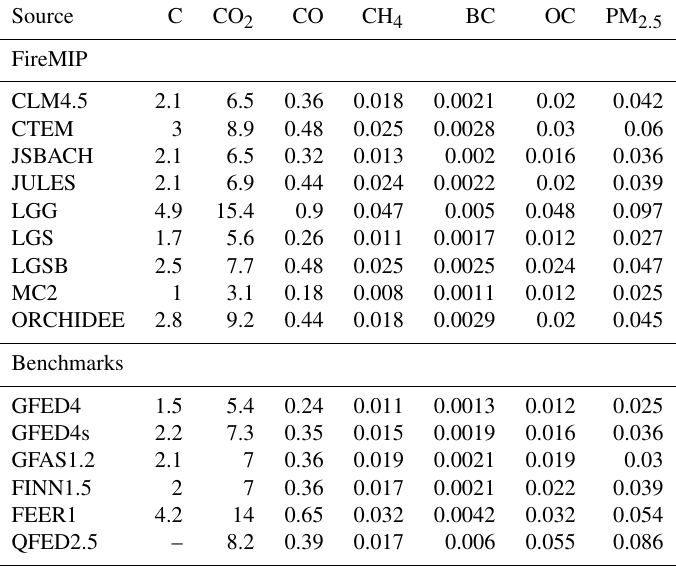
Table 6. Global total of fire emissions from 2003 to 2008 for DGVMs in FireMIP and benchmarks. Unit: Pg (Pg = 10 15 g). Source C CO 2 CO CH 4 BC OC PM 2 . 5 FireMIP